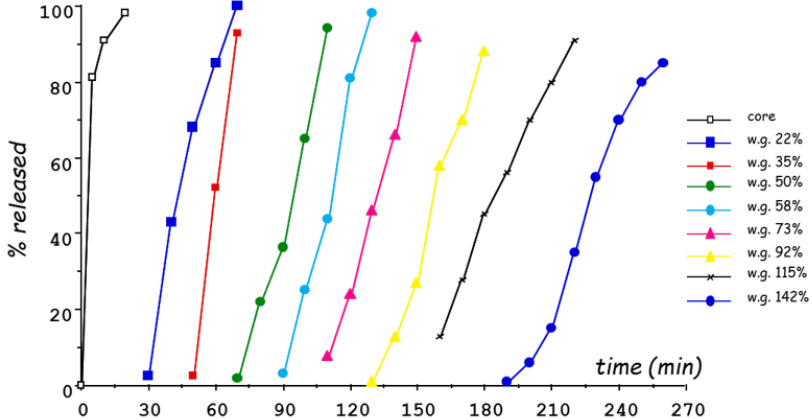
Figure 20. Release profiles of a tracer substance from uncoated tablets and systems spray-coated with Methocel ® E50 to increasing weight gains. Adapted with permission from Ref. [58]. 2009, John Wiley & Sons.